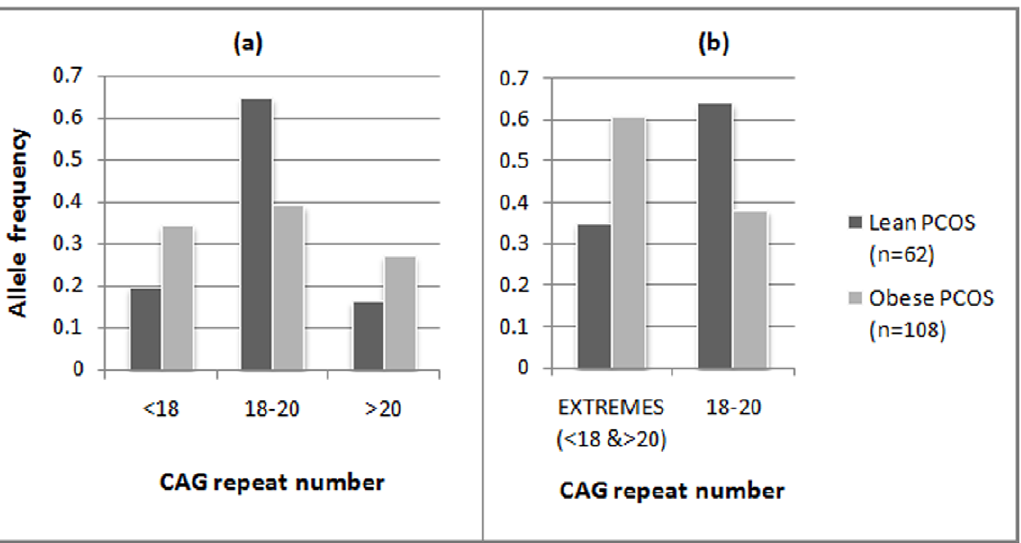
Figure 3. Qualitative distribution of CAG biallelic mean among Lean and Obese PCOS cases. ( a ) for the three categories,i.e, , 18, 18–20 and . 20, ( b ) for extreme CAG categories ( , 18 and . 20) vs the middle range (18–20).